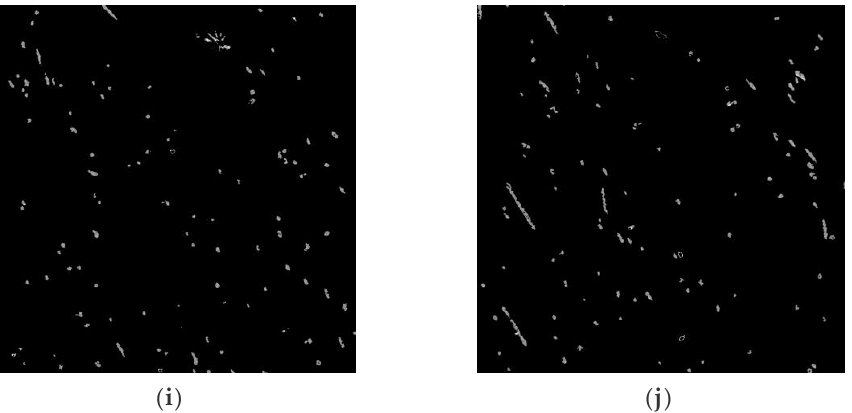
Figure 8. Two-dimensional sectional images of the oriented specimen. ( a ) Image 100; ( b ) Image 200; ( c ) Image 300; ( d )Image 400; ( e ) Image 500; ( f ) Image 600; ( g ) Image 700; ( h ) Image 800; ( i ) Image 900; ( j ) Image 1000.